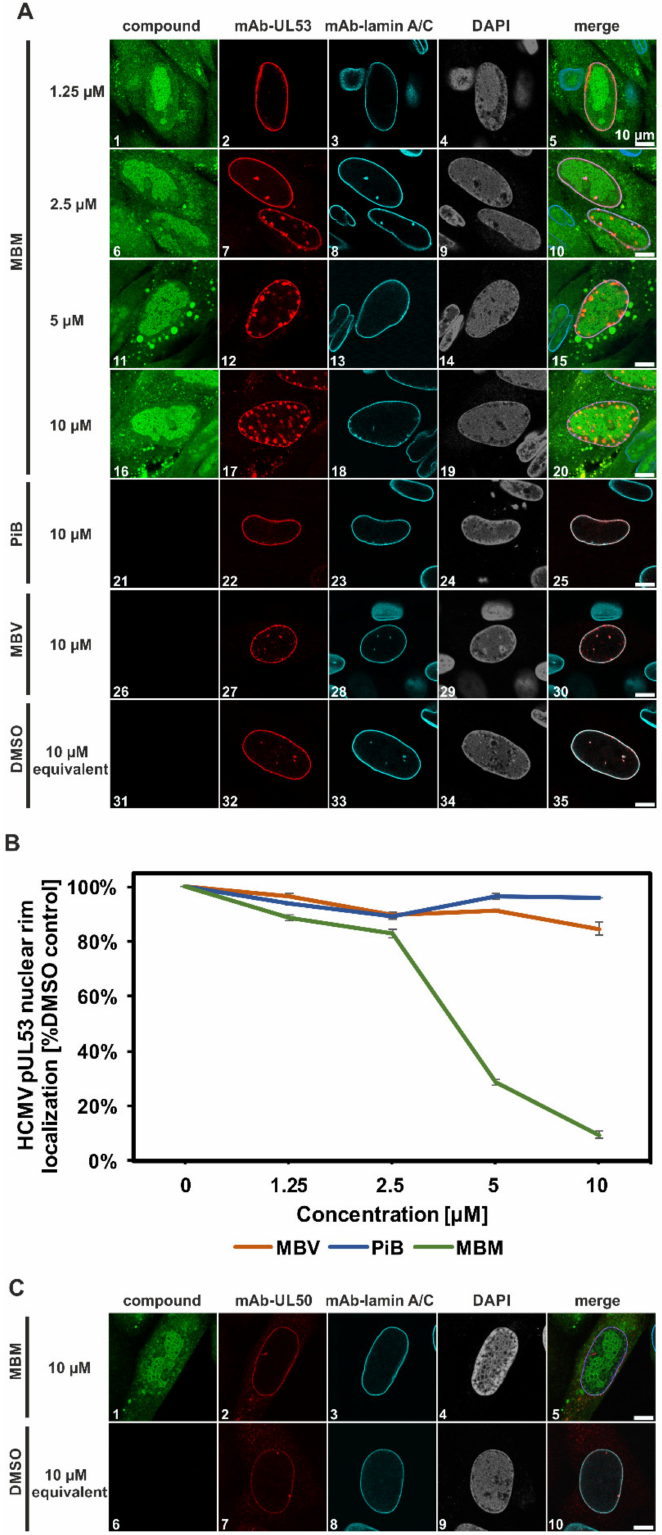
Figure 8. Confocal imaging of NEC nuclear rim formation in HCMV-infected fibroblasts under MBM treatment. ( A ) Human foreskin fibroblasts (HFFs) were cultivated in 6-well plates on cover slips, used for HCMV infection at a multiplicity of infection (MOI) of 0.1 and fixed at 5 d p.i. Indirect immunofluorescence staining was performed for viral pUL53 and cellular lamin A/C.